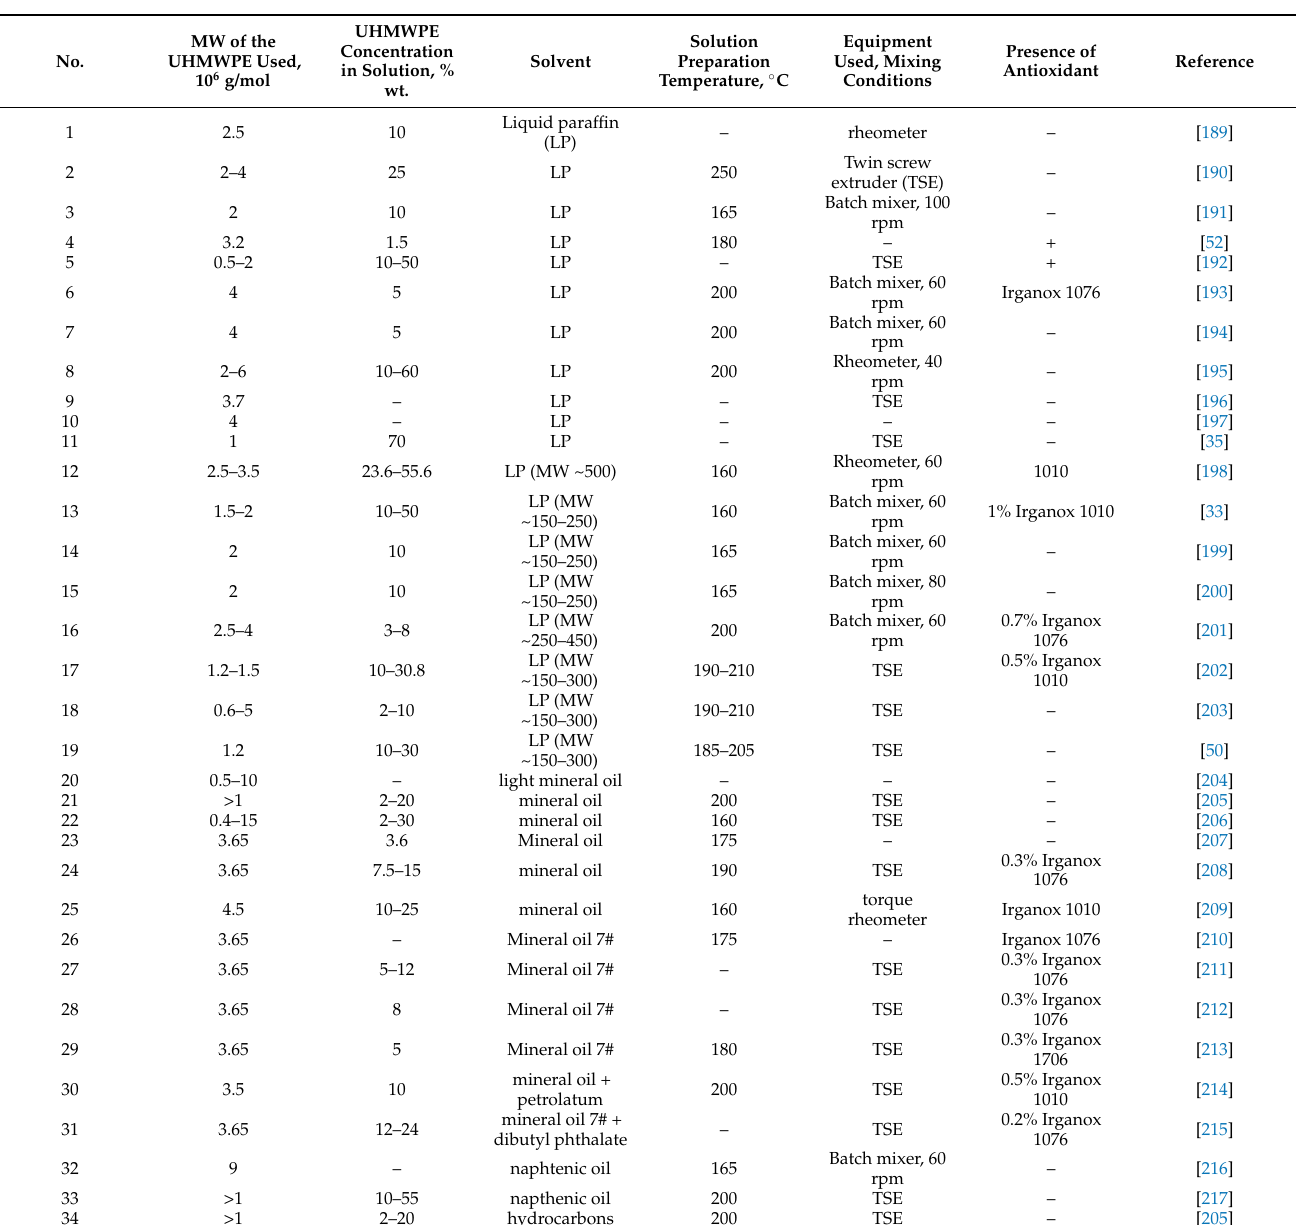
Table 1. Conditions for preparing homogeneous ultra high molecular weight polyethylene (UHMWPE)